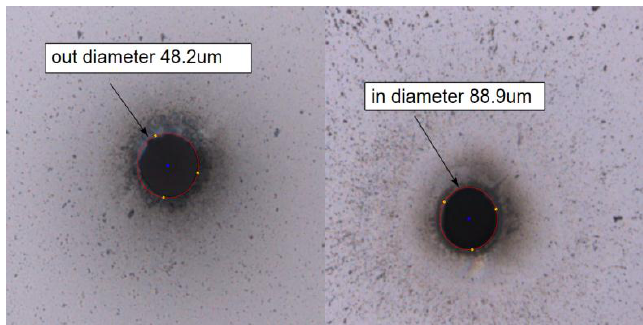
Figure 2. Picture of a via hole drilling using optimized parameters.